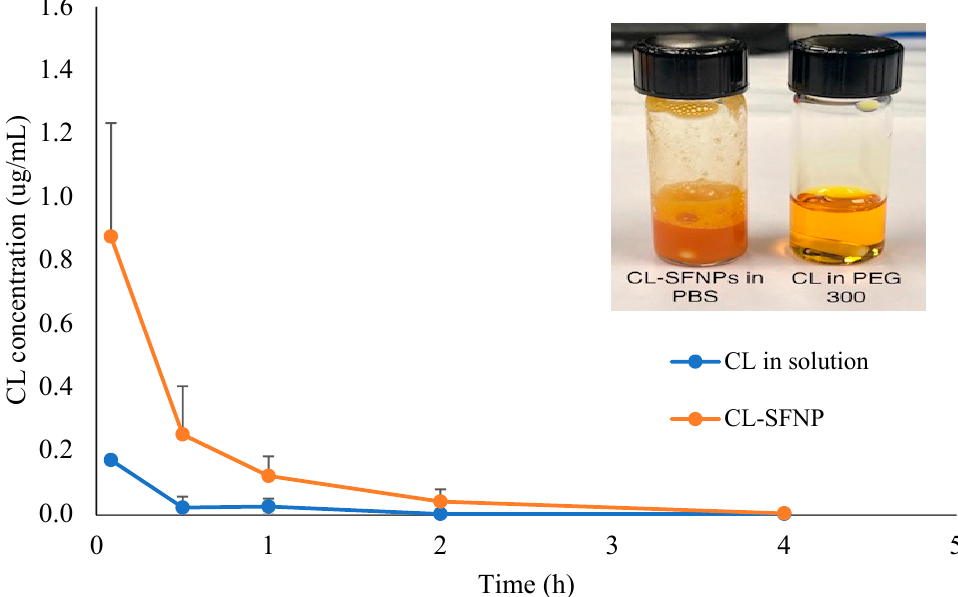
Figure 4. CL plasma concentration–time profiles in rats following intravenous (IV) administration of CL and celastrol-loaded silk fibroin nanoparticles (CL-SFNP). The insert shows the physical appearance of the respective formulations. Table 5. Pharmacokinetic parameters of CL following single intravenous dose of pure CL and CL-SFNP at 1 mg/kg (n = 3).